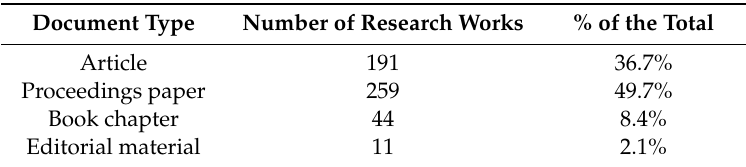
Table 1. The breakdown by the document type of the initial pool of contributions on ERM for the period